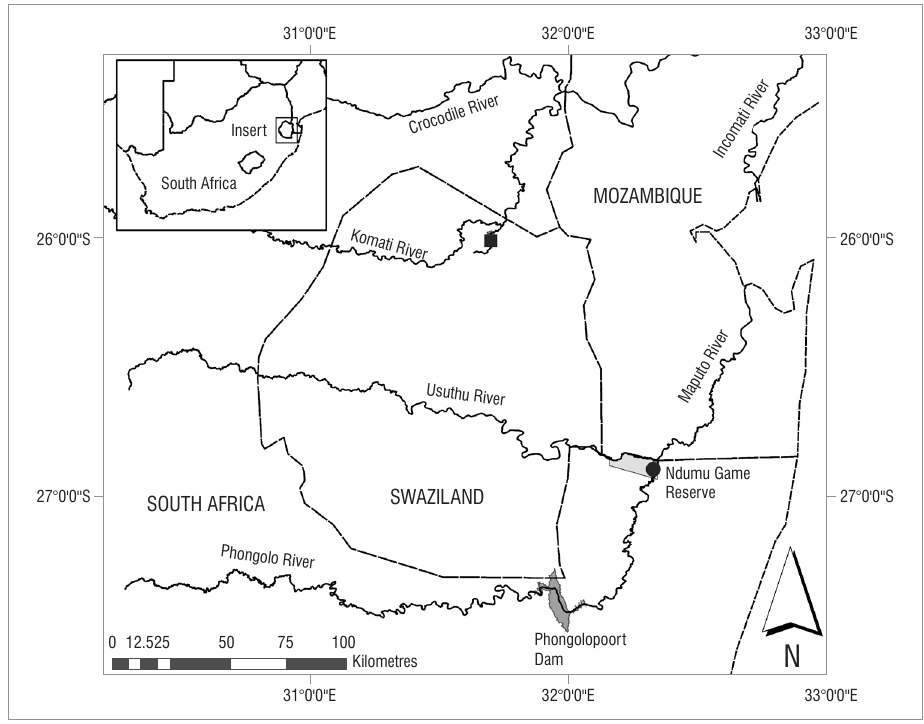
Figure 1: Map showing the location of a previously reported alien population of Cherax quadricarinatus (square) in the Sand River Dam in Swaziland 11 and the current record (circle) of the same species at the outlet of Lake Nyamiti (26.882775 S, 32.311393 E) in the Ndumu Game Reserve,